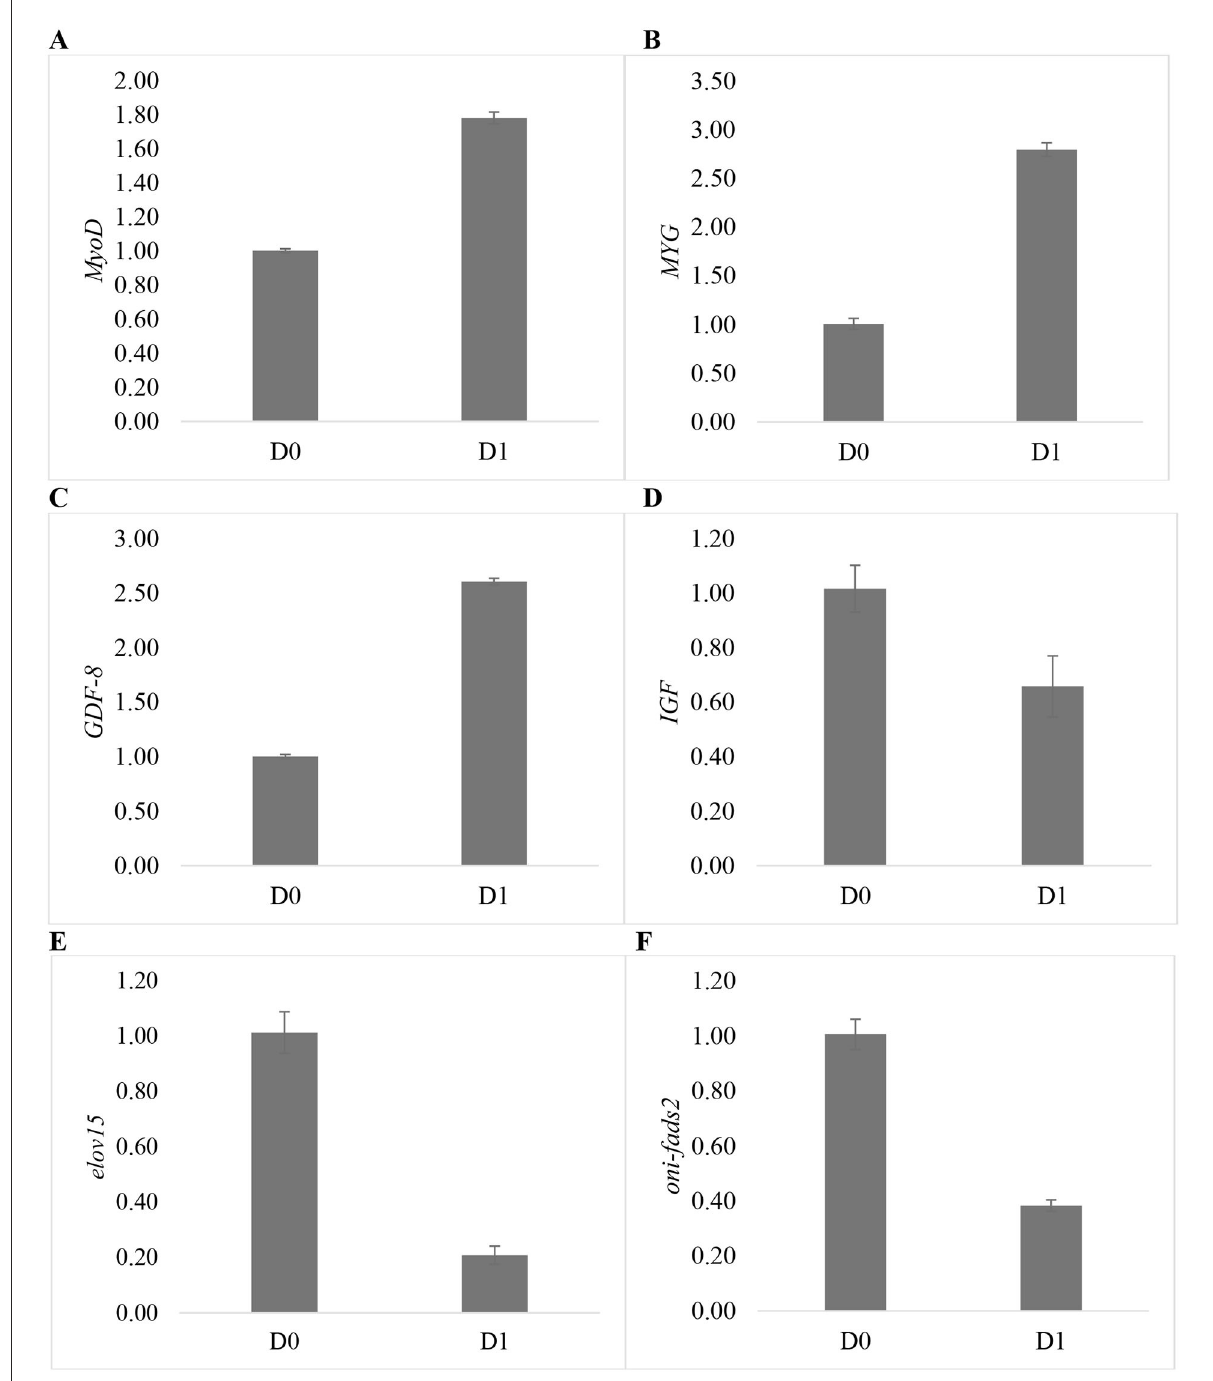
FIGURE3 Relative mRNA levels of different genes expressed in the muscle and liver of seawater-tolerant tilapia fed with 2.55% T. weissflogii paste. (A) MyoD , (B) MyG , (C) GDF-8 , (D) I GF , (E) elovl5 , and (F) oni-fads2